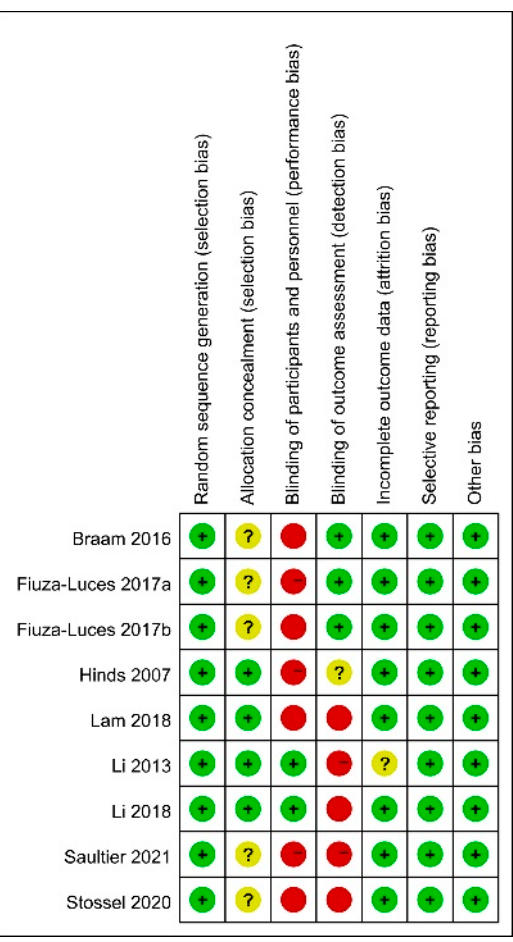
Figure 2. Quality of included studies.